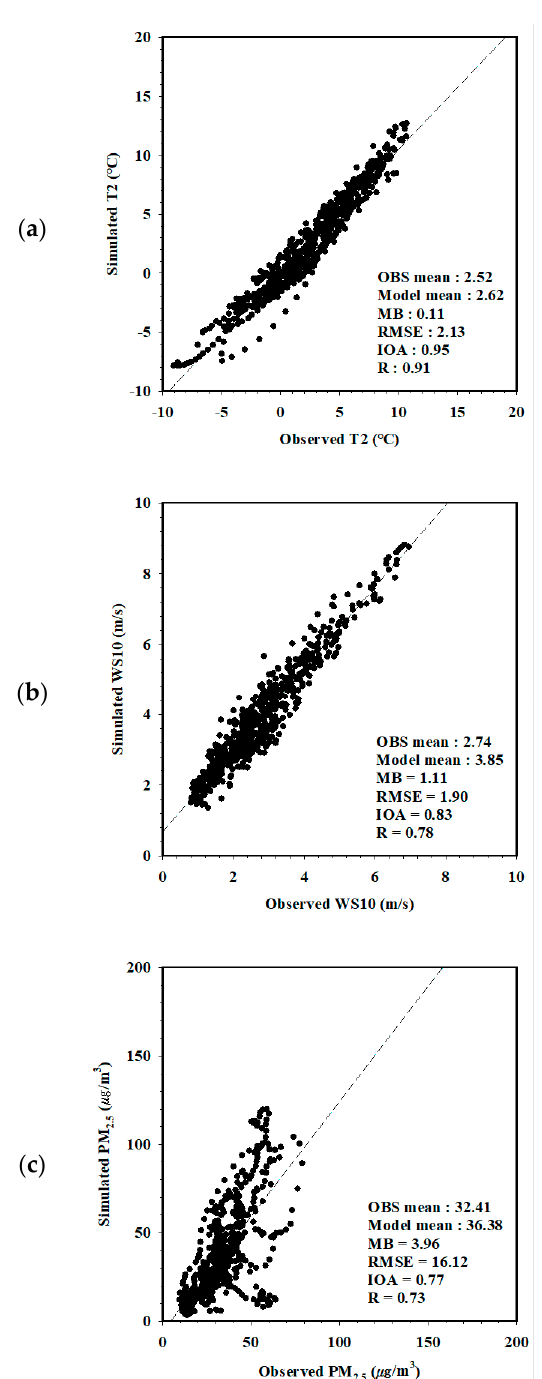
Figure 2. The comparison of hourly observation and model values for ( a ) 2 m temperature (T2), ( b ) 10 m wind speed (WS10), and ( c ) PM 2.5 concentration. “OBS” is observation, “MB” is mean bias, “RMSE” is root mean squared error, “IOA” is index of agreement, and “R” is correlation coefficient.